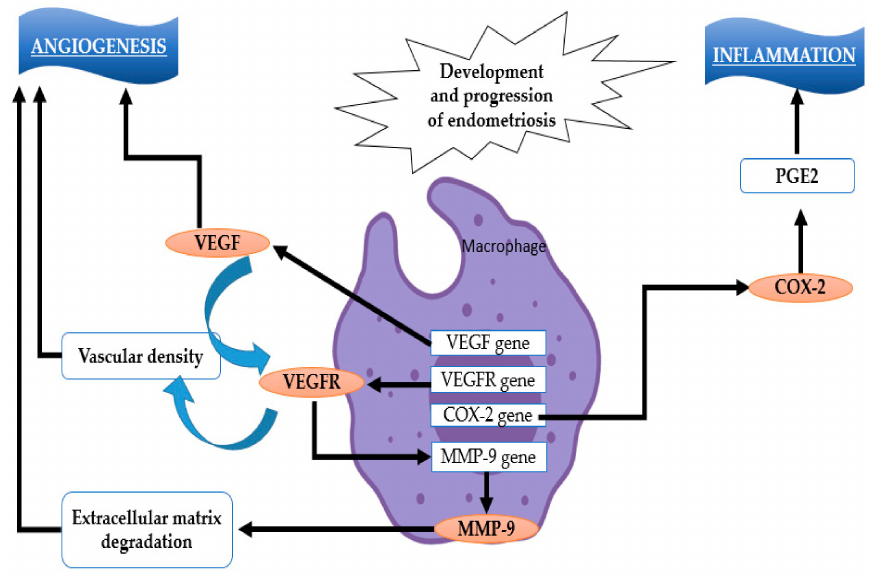
Figure 2. Angiogenesis process—In endometriosis, the central role in pathophysiological mechanisms is attributed to macrophages. These cells increase the intranuclear expression of vascular endothelial growth factor (VEGF) and cyclooxigenase 2 (COX-2) genes, leading to increased angiogenesis and an inflammatory environment